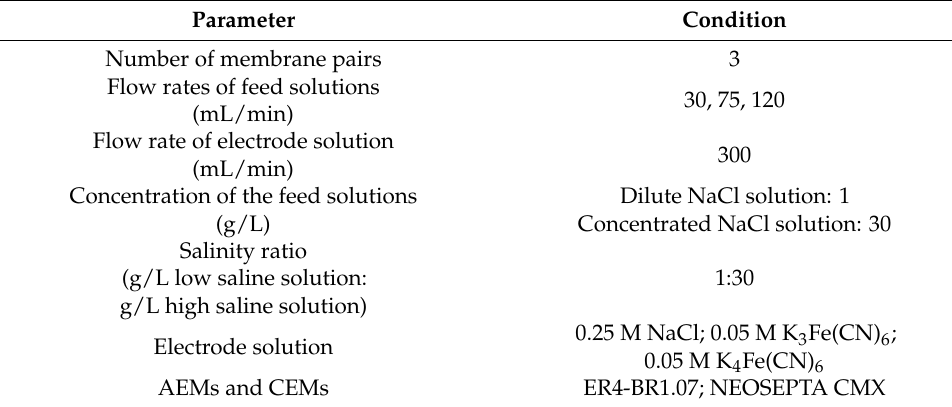
Table 7. Operational parameters for RED tests.